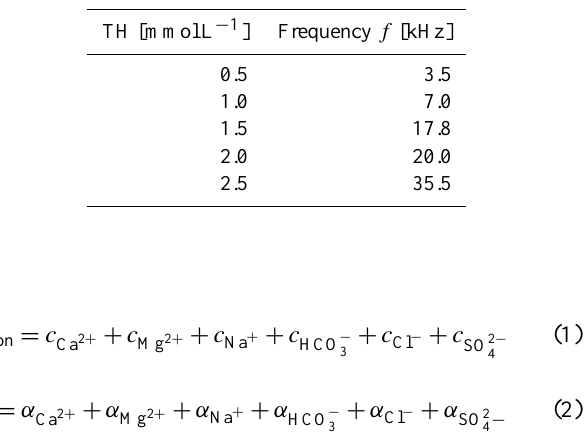
Figure 3. Dependence of the impedance spectra on total hardness of water. Table 2. MTP frequencies of the impedance spectras of Fig.